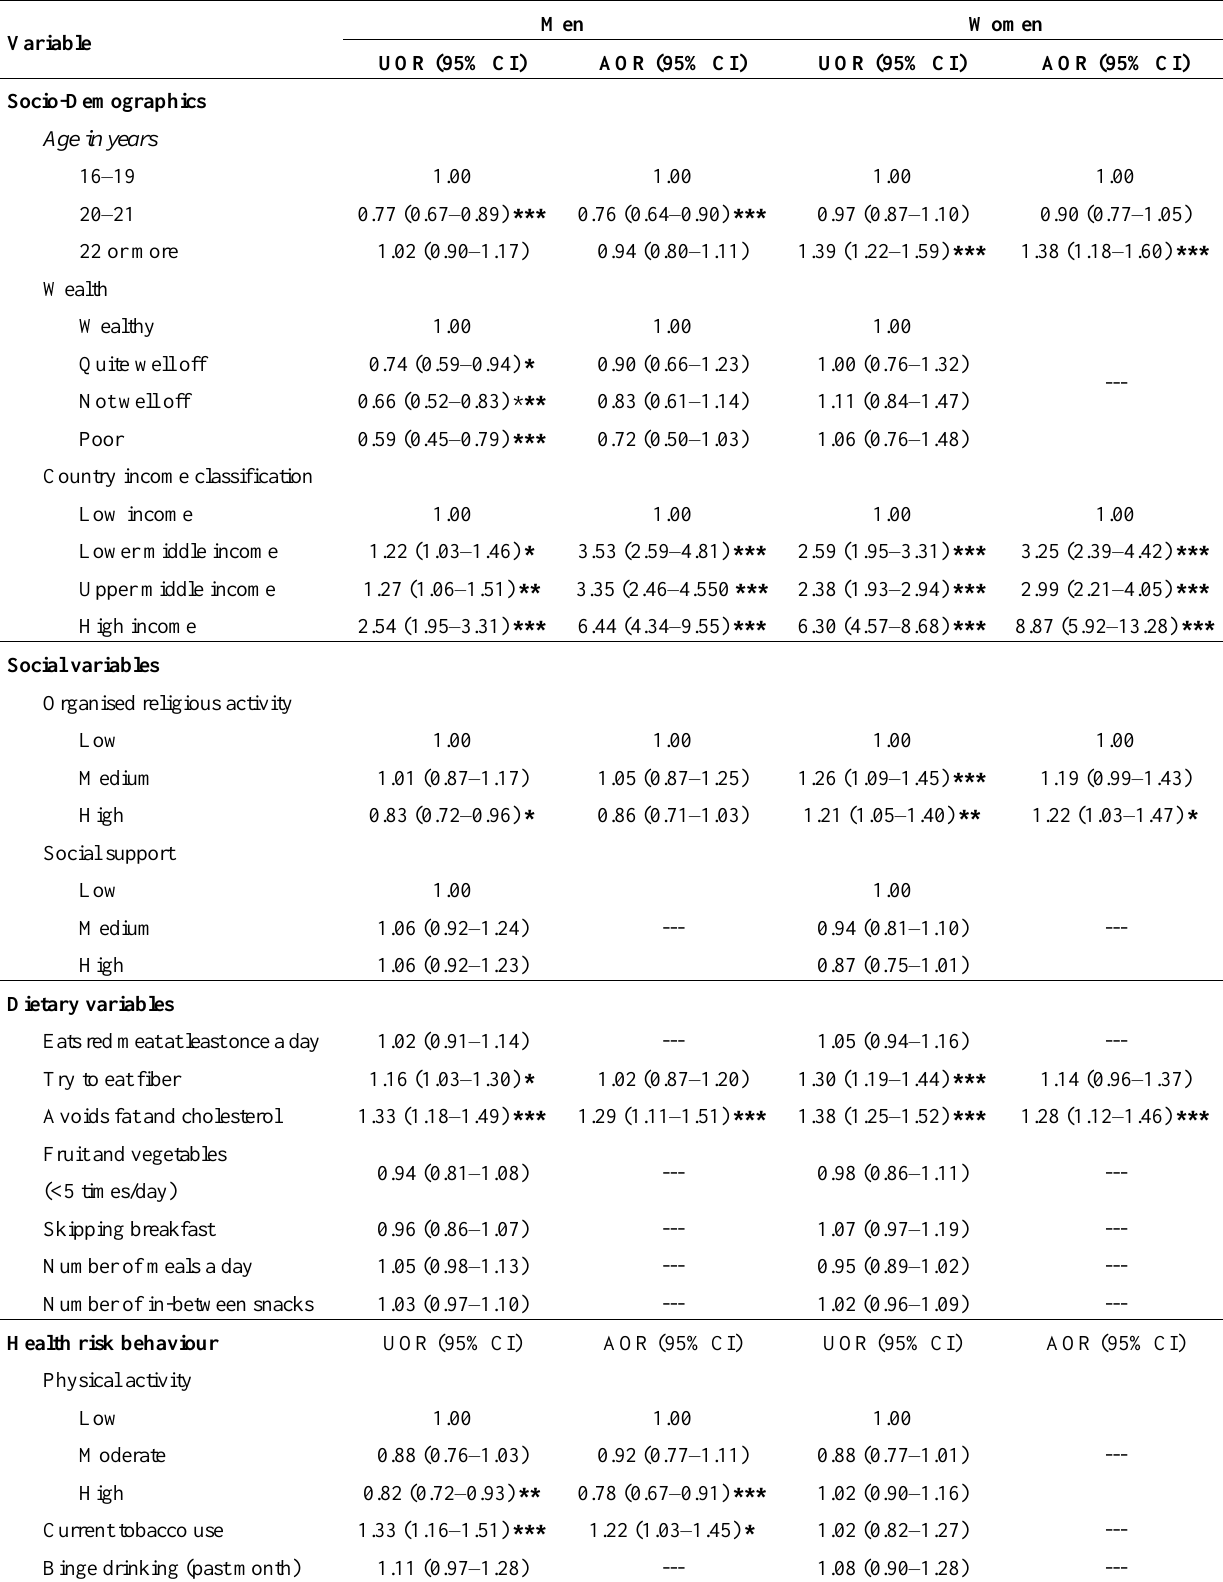
Table 4. Associations between BMI overweight/obesity and social, dietary, health behaviours, mental health and abuse in university students from 22 low and middle income and emerging economy countries,